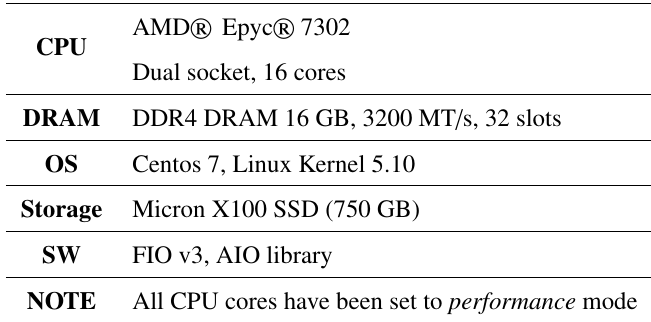
Table 1. Overview of the test machine used for the